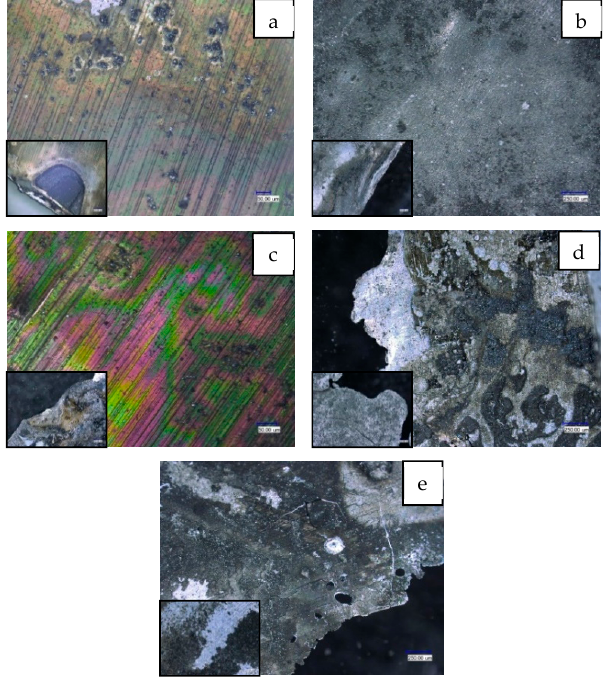
Figure 7. Aluminum foil after treatment: ( a ) Reference; ( b ) MW 220 °C; ( c ) MW 360 °C; ( d ) MW 418 °C; and, ( e ) MW 501 °C.